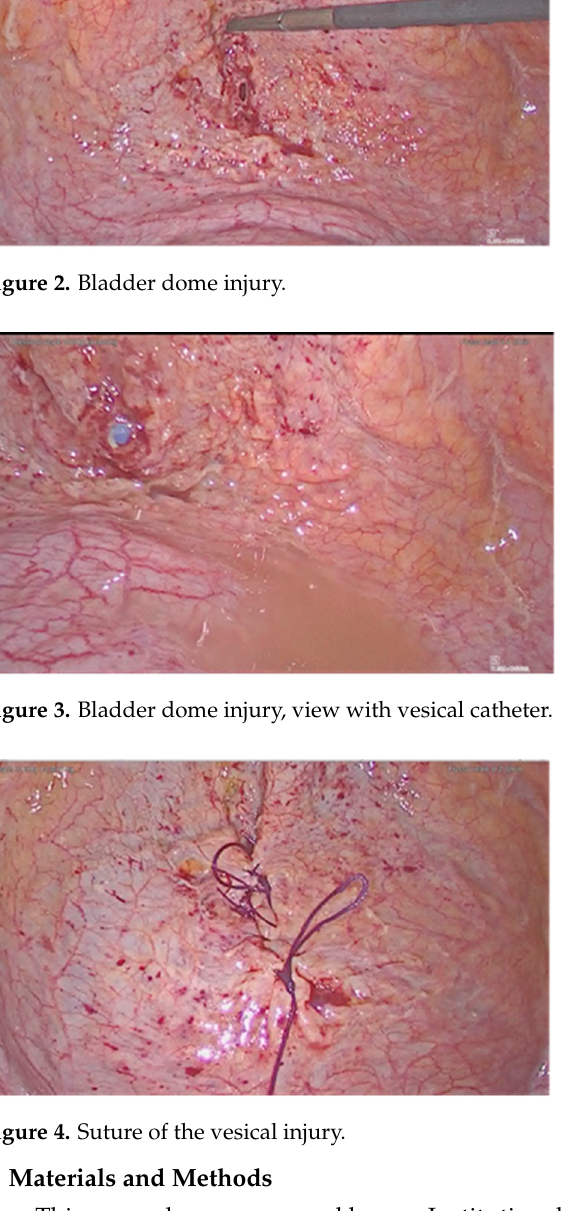
Figure 4. Suture of the vesical injury.